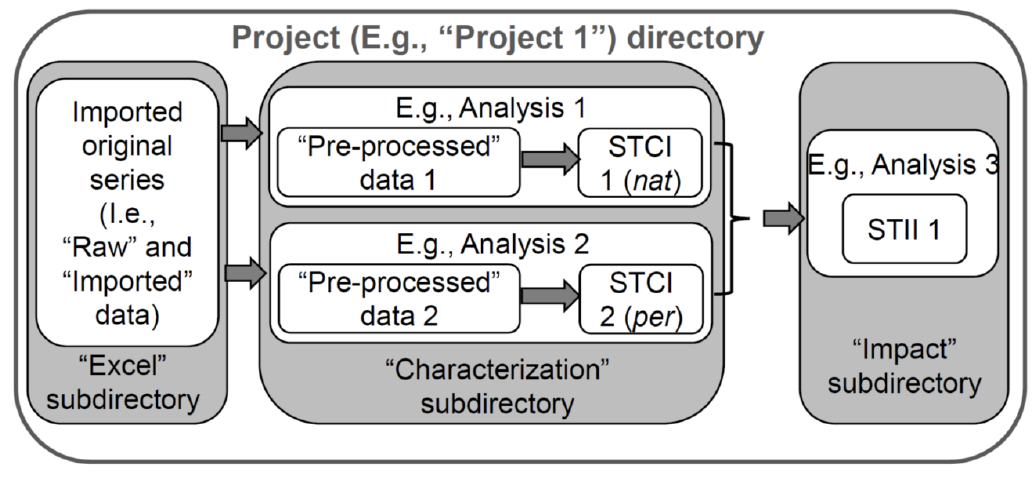
Figure 2. General organization of InSTHAn.